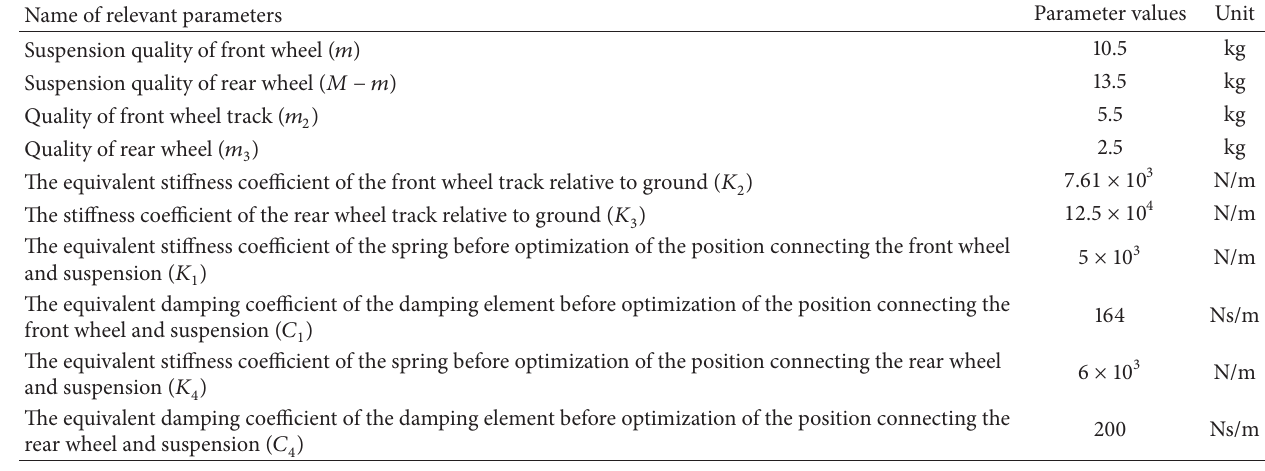
Table 1: Performance parameters of the wheel-tracked